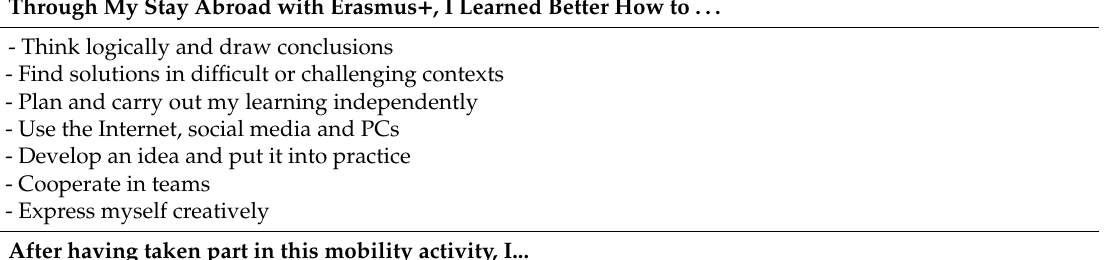
Table 1. Questionnaire items related to the competencies developed.